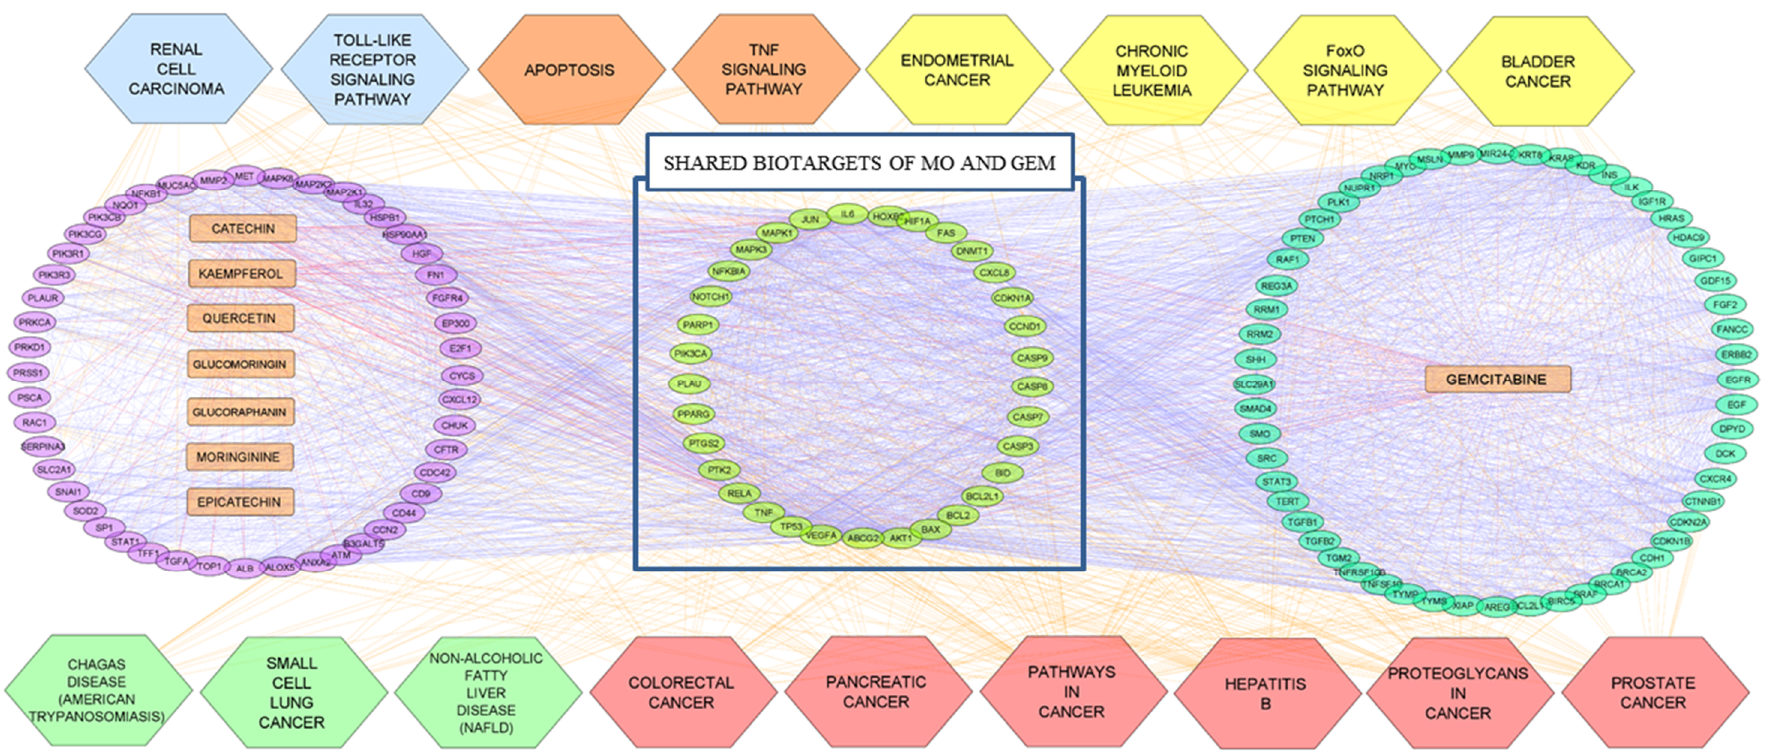
Figure 6. The compound-target-pathway network of MO and GEM, as well as the shared biotargets intersection against pancreatic cancer, by using Cytoscape. The network contains 162 nodes (8 compounds, 17 pathways, and 137 target genes) and 3227 edges. The left and right compound-target network are the MO and GEM intersections target genes, respectively, while the center compound-target network is their combination against pancreatic cancer. The light blue hexagons represent the pathways involved in MO intersection targets, the orange hexagons represent the pathways involved in the MO and shared biotargets intersections, the yellow hexagons represent the pathways involved in the GEM intersection targets, the green hexagons represent the pathway involved in shared biotargets intersection, and the pink hexagons represent the pathway involved in three intersection networks. The oval nodes represent the target genes, the rectangle nodes represent the compounds, the hexagons represent the signaling pathway, while the edges represent the interaction between them .